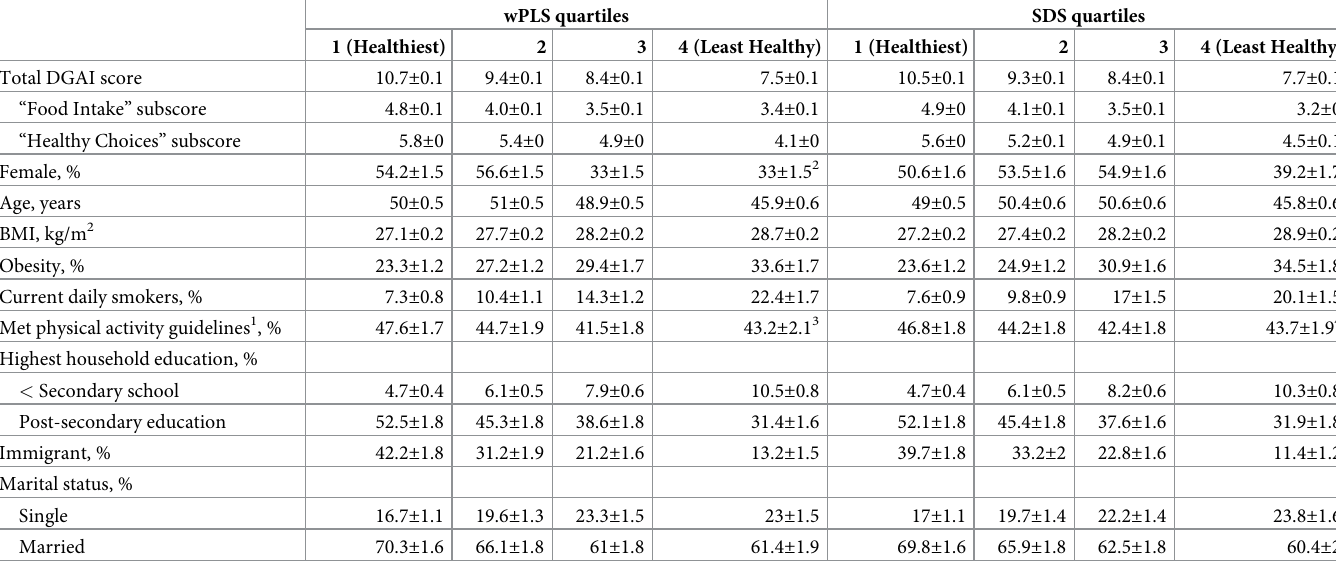
Table 1. Analysis of sociodemographic and lifestyle characteristics across quartile categories of the energy-dense, high-fat and low-fiber density (“obesogenic”) die- tary pattern score generated from wPLS, and the simplified dietary pattern score (SDS) among Canadian adults from CCHS-Nutrition 2015 ( n = 12,049).